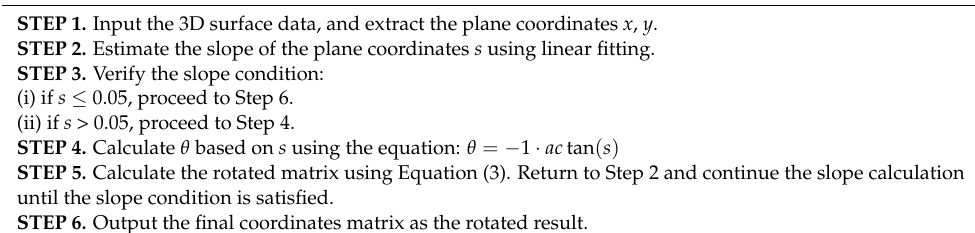
Algorithm 1. Numerical Algorithm for Coordinates Rotation